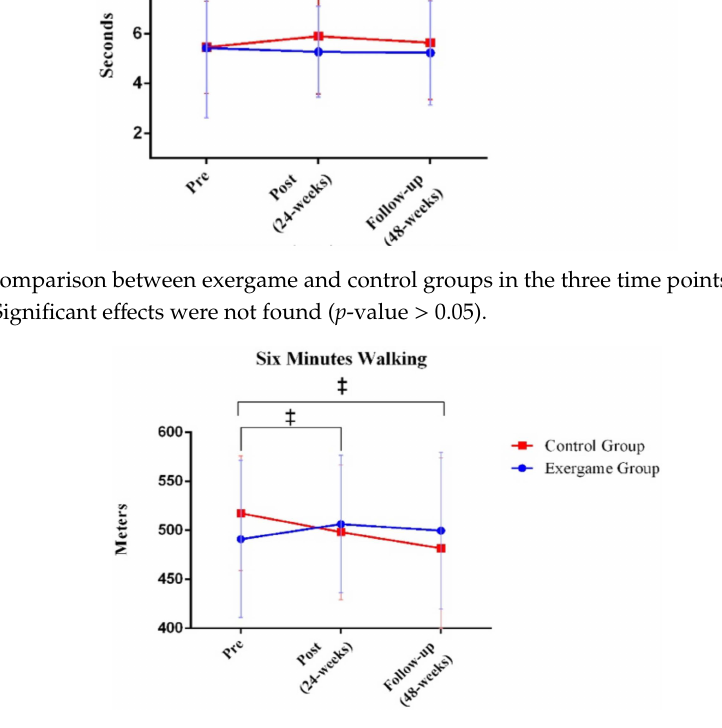
Figure 4. Comparison between exergame and control groups in the three time points for the 6-min Walking Test. ‡ The control group significantly decreased the number of meters ( p -value <